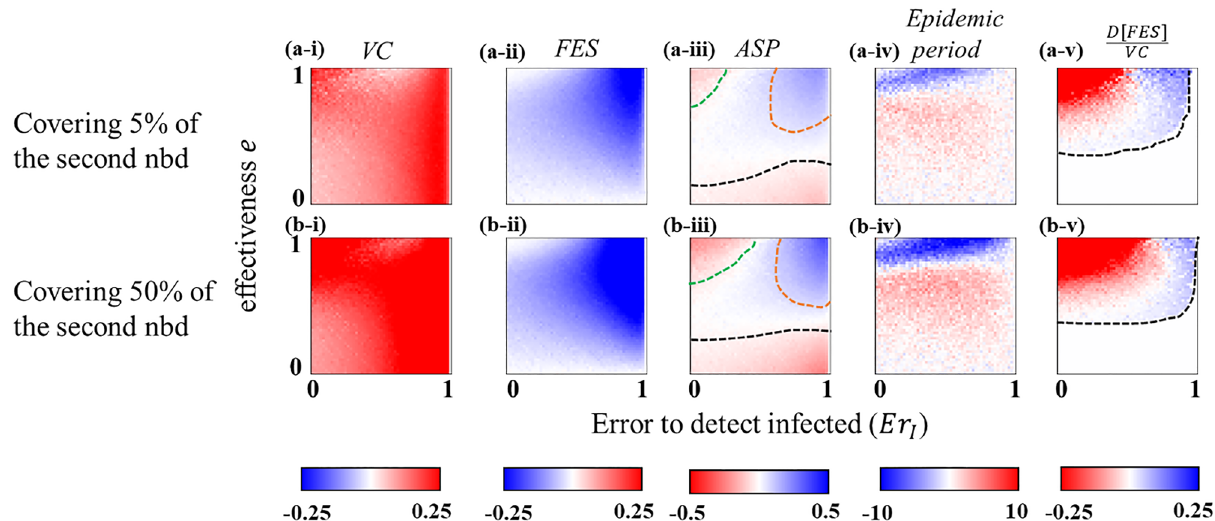
Figure 5. Expansion of the vaccination target. Results are obtained by subtracting outcomes focusing only on the first neighborhood as the vaccination target (i.e., the default case as in Fig. 3a,b) from that of the expansion to the second neighborhood (covering 5% (upper panel) and 50% (lower panel)). Quantity of interests, from left to right, chronologically depict vaccination coverage ( a-* ), final epidemic size ( b-* ), average social payoff ( c-* ), total time until the end of the disease prevalence ( d-* ), and ( e ) the efficiency in reducing FES by a single vaccination dose. In the right most column, we define D [ FES ] / VC = ( FES VC = 0 − FES )/ VC . In the case of ASP (panel ( *-iii )), blue (red) stands for a better(worse) outcome in the extended range of vaccination targets. Obviously, it would require more vaccination coverage (yielding less FES) in the case of extended vaccination targets. With regard to the overall social gain ( ASP defined in Eq. (1)), it would be beneficial to extend vaccination targets to the second neighborhood when vaccines are highly effective, and the detecting error is quite large (blue region enclosed by orange dotted line panel ( *-iii )). The expansion to the second neighborhood would require less time to end the disease prevalence only when vaccines are highly efficacious (blue region in panel ( *-iv )). The black dotted line in panels ( *-v ) depicts the boundary above which FES ≤ 0.45 . Below this line, the dynamic vaccination fails to confine the diseases spreading. Relevant parameters values are stated in Table heatmap although VC ( FES ) seems larger (smaller) in the extended neighborhood version (see panels (*-i) and (*-ii) in Fig. 5). We provide reasoning for such variations in ASP for three different scenarios. (i) Highly effective